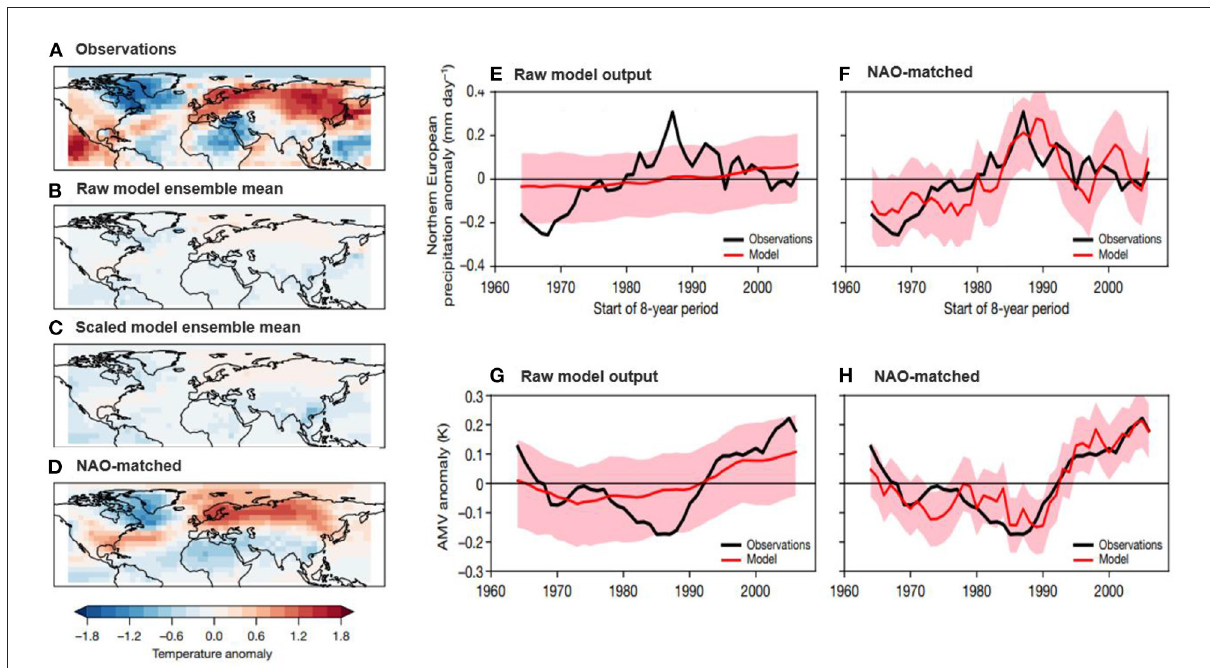
FIGURE1 The need for new approaches to assess model output. Near surface temperature anomalies for the extreme NAO period (1986–1997) in (A) observations, and decadal predictions shown as (B) raw ensemble mean, (C) scaled ensemble mean to match the observed variance at each grid point, (D) NAO-matched ensemble mean. Middle and right columns show observed 8-year mean time-series (black) and decadal predictions (years 2–9, ensemble mean in red with 5–95% confidence interval shaded) as raw ensemble means (middle) and NAO-matched ensemble means (right) for (E,F) northern European rainfall (10 ◦ W − 25 ◦ E, 55–70 ◦ N) and (G,H) AMV index (Trenberth and Shea, 2006). Decadal predictions start each year from 1960 to 2005 and consist of a total of 169 ensemble members from 13 different models. (A–D) Show standardized values, obtained by dividing by the standard deviation of rolling 8-year means at each grid point. (A,B) show signals standardized by the observed variability, (C,D) show signals standardized by the ensemble mean variability. NAO-matching is achieved by selecting the 20 ensemble members at each time that are closest to the ensemble mean after scaling this to account for its underestimation of the magnitude of the predictable signal. All panels show boreal winter (December-March) anomalies relative the average over all year 2–9 predictions. Adapted from Smith et al. (2020), where further details are